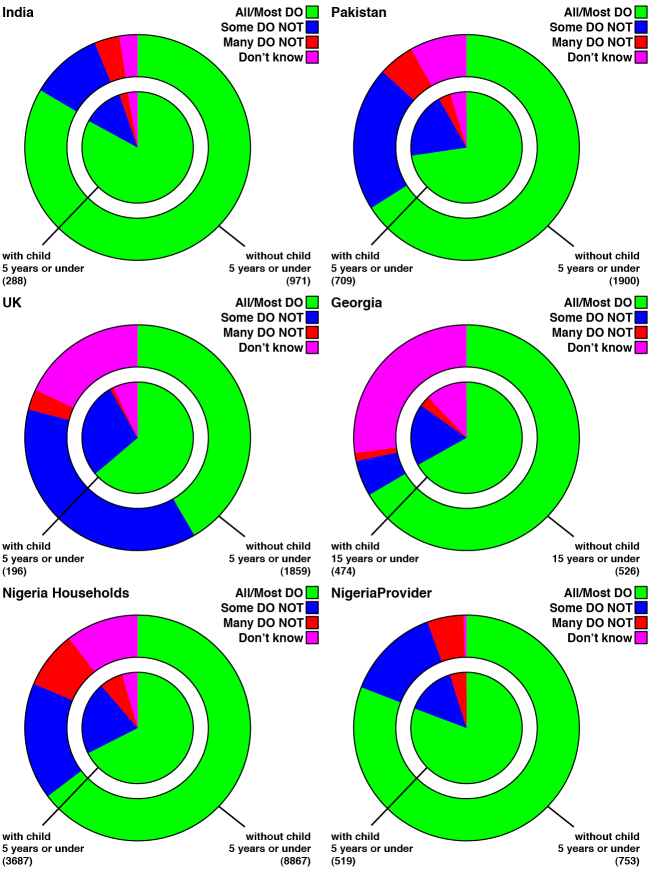

Figure 6: Perceptions of vaccine coverage
This figure compares perceptions of how many people get vaccinated among those respondents without children under 5 (outer ring) to those reported by those with children under five RCU5s (inner circle).